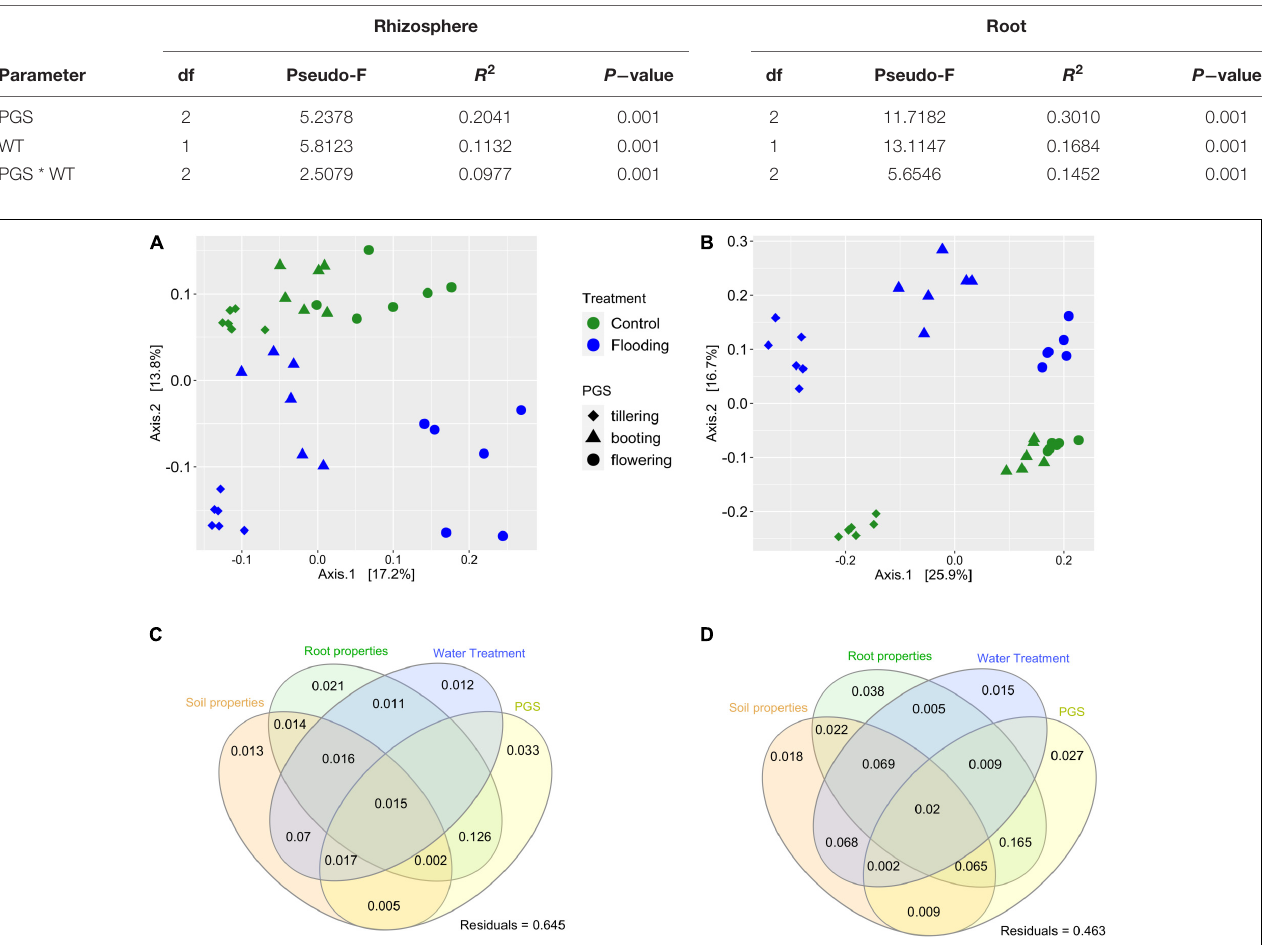
TABLE 2 | The relative importance of plant growth stage (PGS) and watering treatment (WT) for the total bacterial community structure associated to rhizosphere and root compartments in the samples investigated in this study as revealed by PERMANOVA.